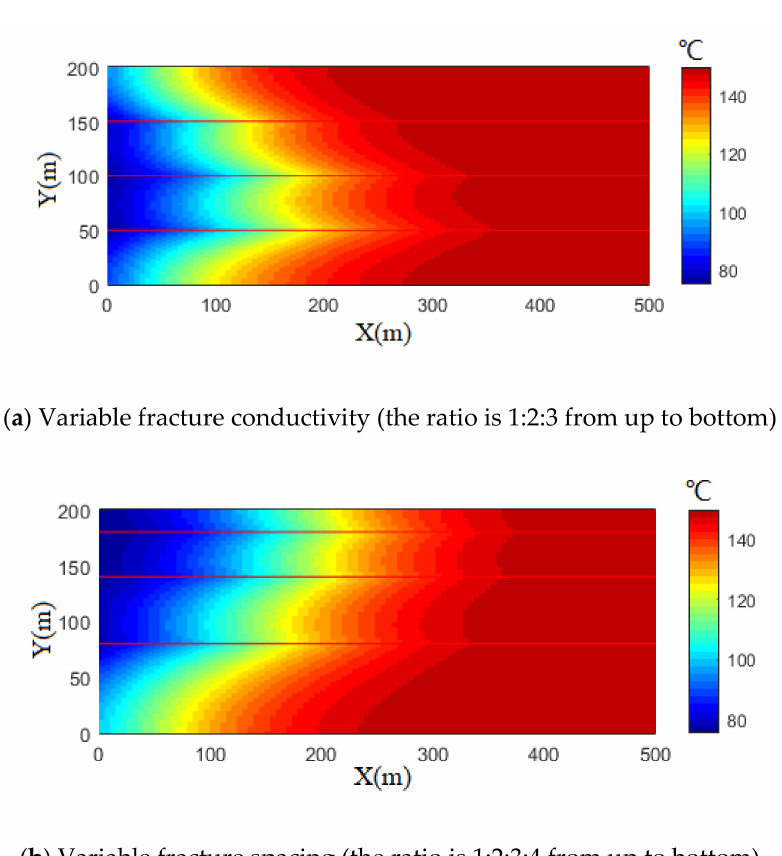
Figure 9. Temperature distribution for variable fracture conductivity and spacing. For the ( a ), the thermal front spreads firstly in the high-condcutivity fracture. For the ( b ), the small fracture spacing leads to early thermal